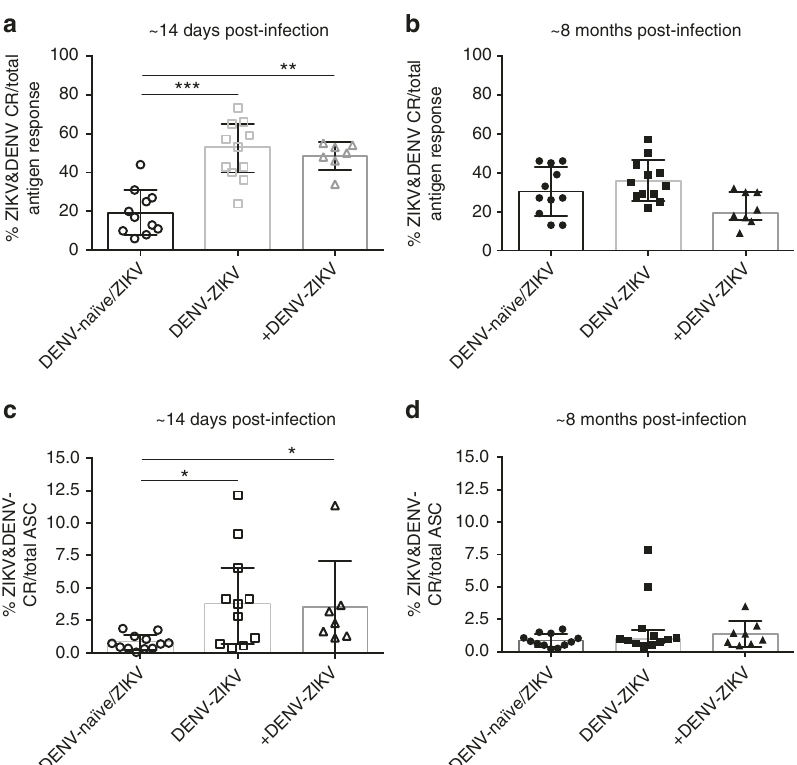
Fig. 3 ZIKV and DENV cross-reactive MBCs decrease over time in ZIKV + patients. ZIKV and DENV cross-reactive B cell responses in ZIKV-infected patients with no (DENV-naïve/ZIKV), one (DENV-ZIKV), or more than one ( + DENV-ZIKV) prior DENV infection are shown. a , b ZIKV and DENV cross- reactive IgG-secreting MBC responses over total antigen response at ~14 days ( a ) and ~8 months ( b ) postinfection. c , d ZIKV and DENV cross-reactive IgG-secreting MBC response over total ASC response at ~14 days ( c ) and ~8 months ( d ) postinfection. Median and IQR are shown for all graphs. Signi fi cance was determined by Kruskal – Wallis test and Dunn ’ s test; * p < 0.05, ** p < 0.01, *** p < 0.001. DENV-naïve, n = 11; DENV-ZIKV, n = 12; + DENV- ZIKV, n = 7 at ~14 days postinfection (one PBMC sample was not viable) and n = 8 at ~8 months of 26%, 36%, and 32.5% in the DENV-naïve/ZIKV, DENV-ZIKV,